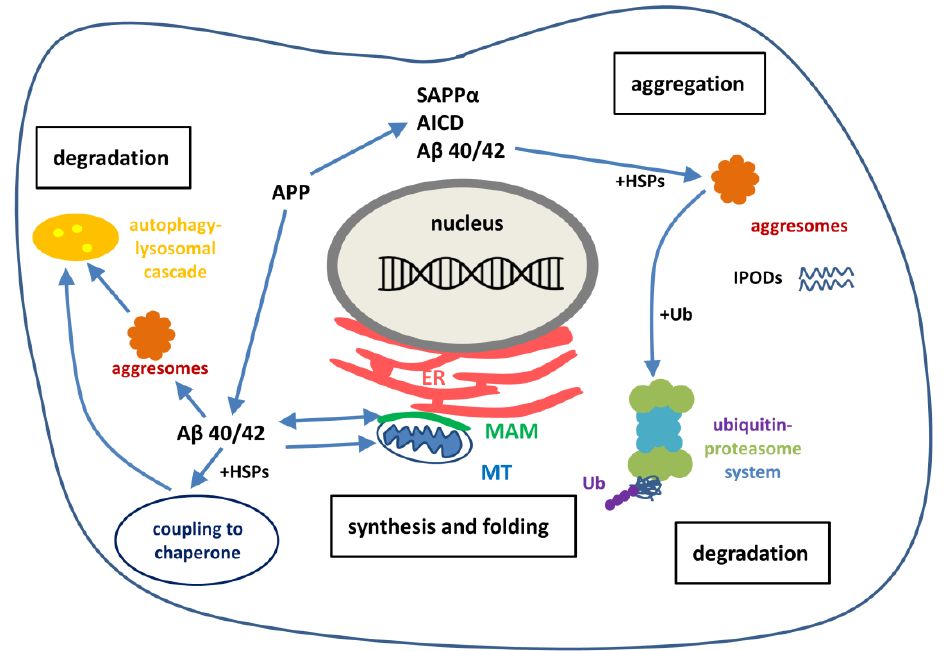
Figure 2. Schematic representation of the intracellular proteostasis network. Cytosolic misfolded proteins are bound by molecular chaperones, such as the HSPs. Molecular chaperones may act as aggregate unfolding and refolding enzymes. Autophagy pathways (chaperone-mediated, micro- and macroautophagy) degrade misfolded proteins. Ubiquitinated proteins are degraded by the ubiquitin-proteasome system. Sequestration of degraded misfolded proteins may form compact aggresomes and IPODs. Proteasome resistant aggresomes become enveloped by autophagosome membranes and transported into the lysosomes for autophagy.